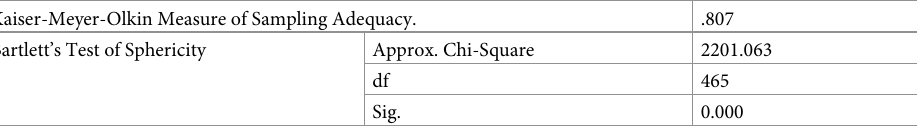
Table 5. Kaiser–Meyer–Olkin and Bartlett’s sphericity tests. Kaiser-Meyer-Olkin Measure of Sampling